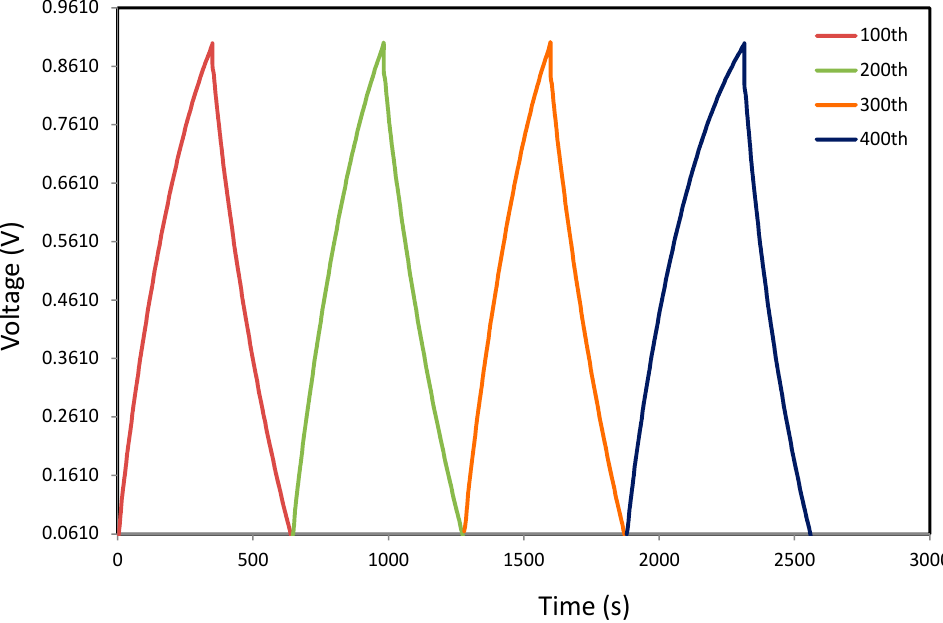
Figure 8. Curves of charge–discharge for the developed EDLC at 0.5 mA cm − 2 for specified cycles.